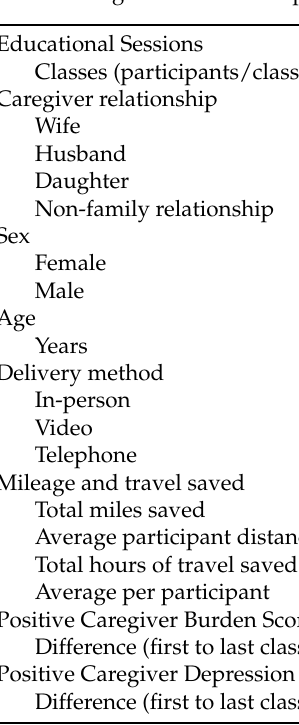
Table 1. Caregivers First Participant Characteristics ( n =